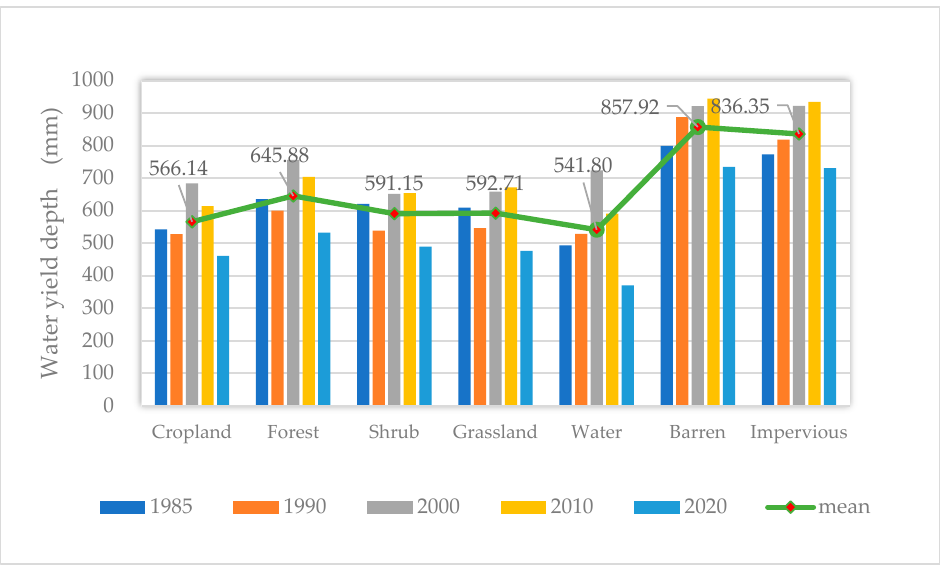
Figure 7. Annual water yield depth of different land types.